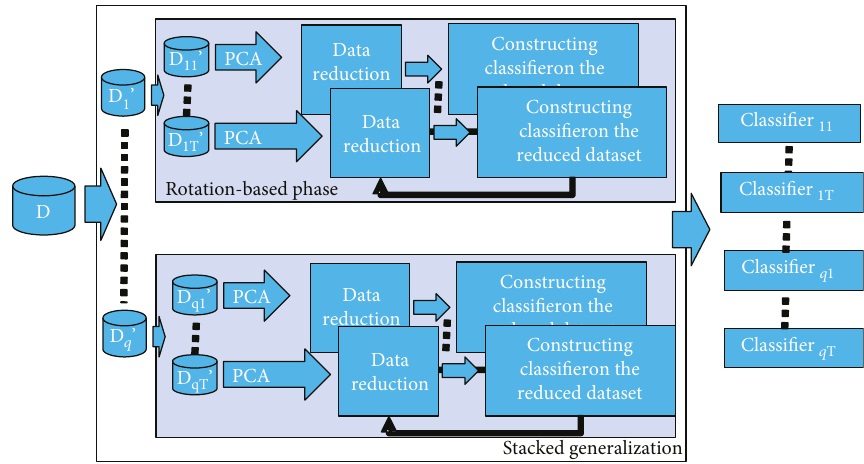
Figure 2: A framework of the proposed approach based on the PCA feature